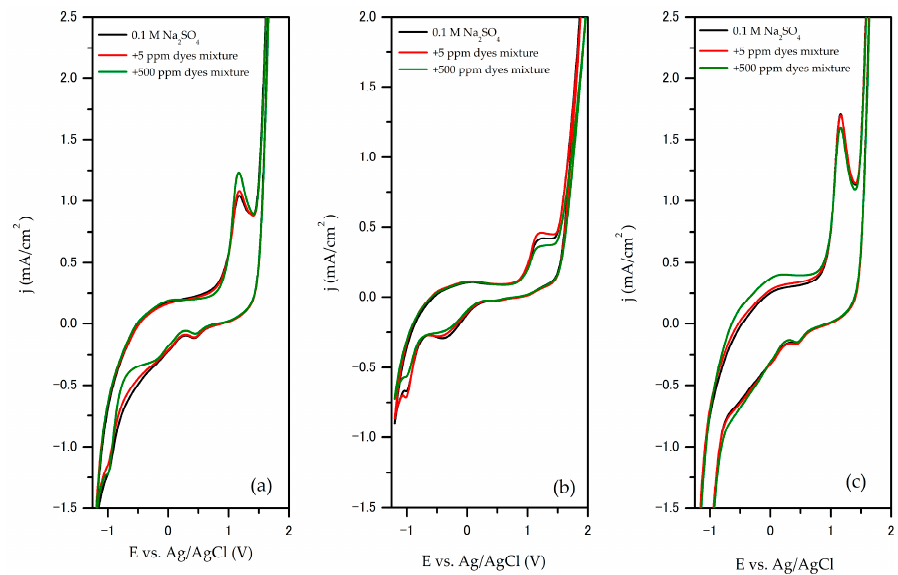
Figure 4. Cyclic voltammograms of ( a ) SnO 2 /GNP@SS; ( b ) TiO 2 /GNP@SS; ( c ) GNP@SS electrodes in 0.1 M Na 2 SO 4 with different concentrations of dyes mixture, at scan speed 100 mV/s.